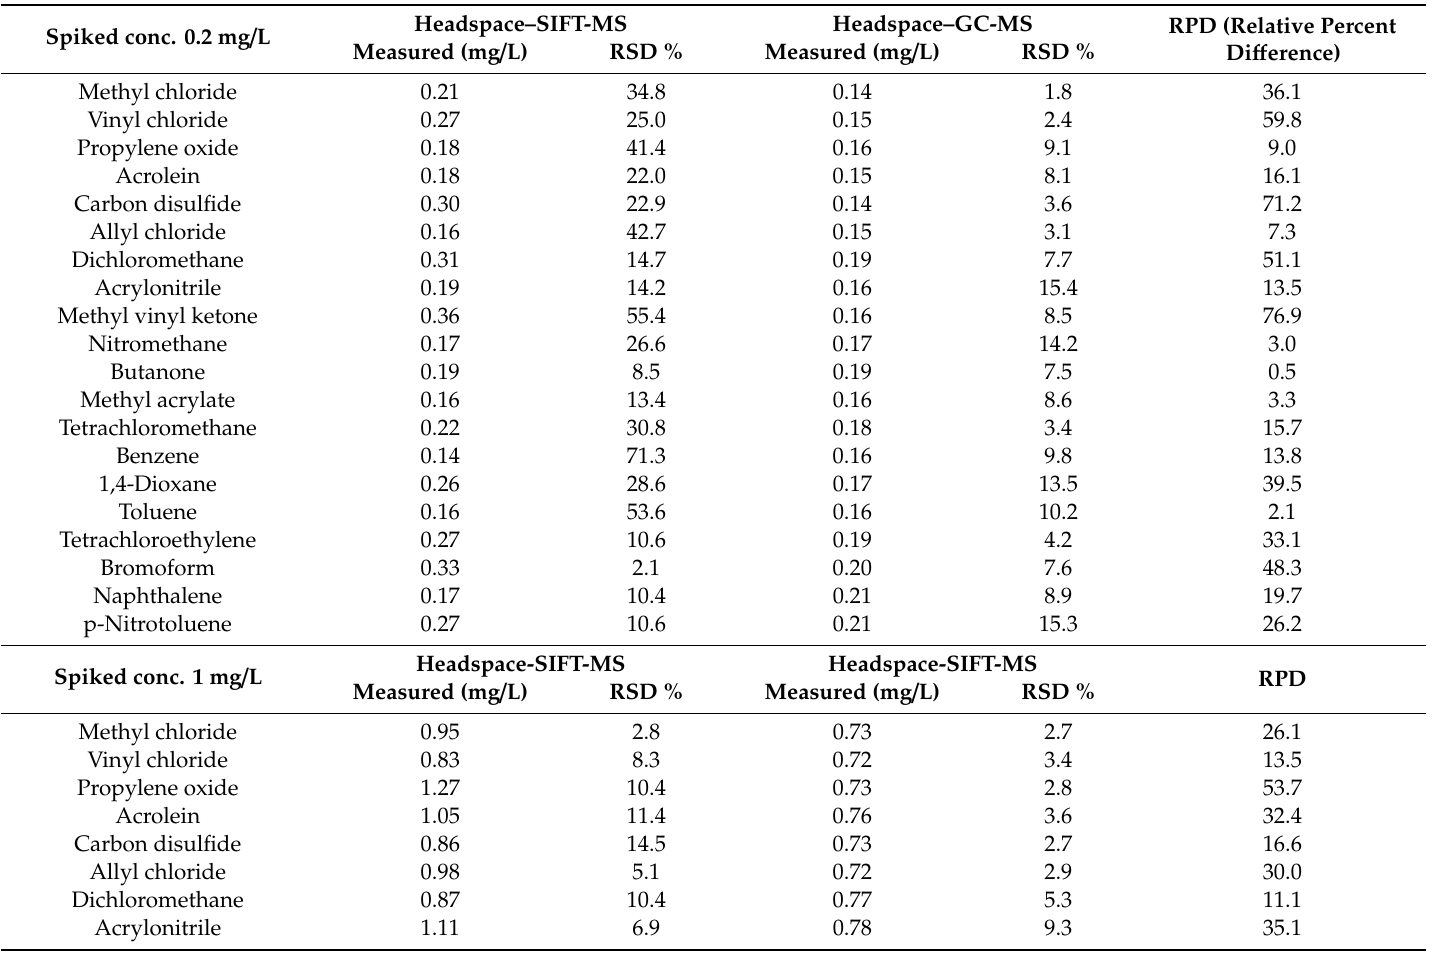
Table 3. Recovery e ffi ciencies of spiked e ffl uent samples in low and high concentrations. Spiked conc. 0.2 mg /